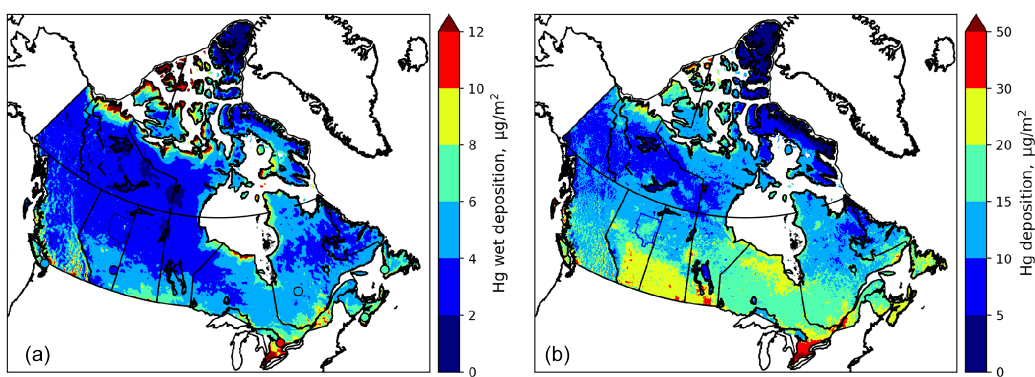
Figure 11. Model-simulated and observed annual Hg wet deposition for 2013 (a) (colours in circles show observed wet deposition for 2013) and simulated annual total Hg deposition (b) (wet plus dry deposition) in Canada for